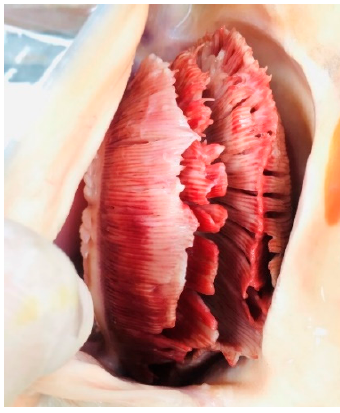
Figure 2. The gill of carp edema virus-infected fish ( Cyprinus carpio koi) showing severe swelling of the primary filaments and necrosis of gill tissue.